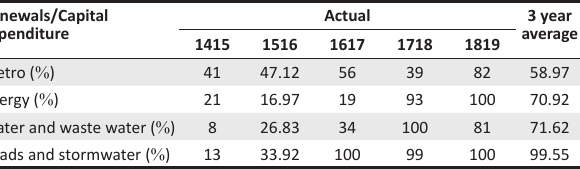
TABLE 4: Renewals over Capex.